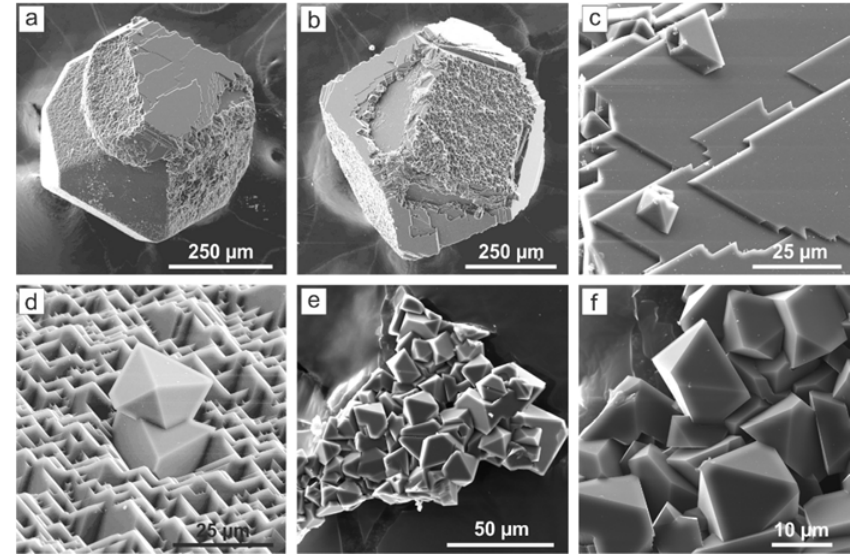
Figure 1. SEM micrographs of diamonds after run with Eu oxalate melt (run ES-8): ( a , b ) seed crystals with overgrown diamond layers; ( c ) {111} face with macrolayers of growth and spontaneous diamond crystals; ( d ) {100} face with spontaneous diamond crystals; ( e , f ) intergrowth of spontaneous diamond crystals.